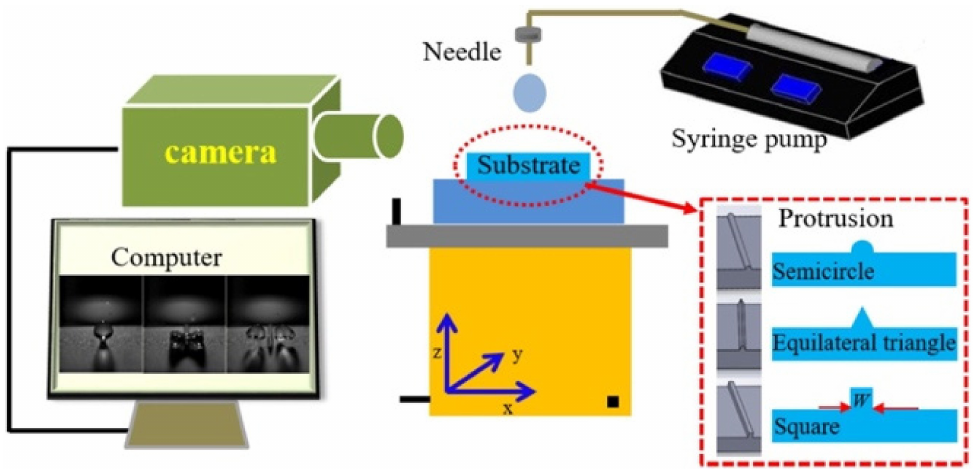
Figure 26. Experimental setup to monitor drop impacts on surfaces with various protrusions (Reprinted from [188] with permission from